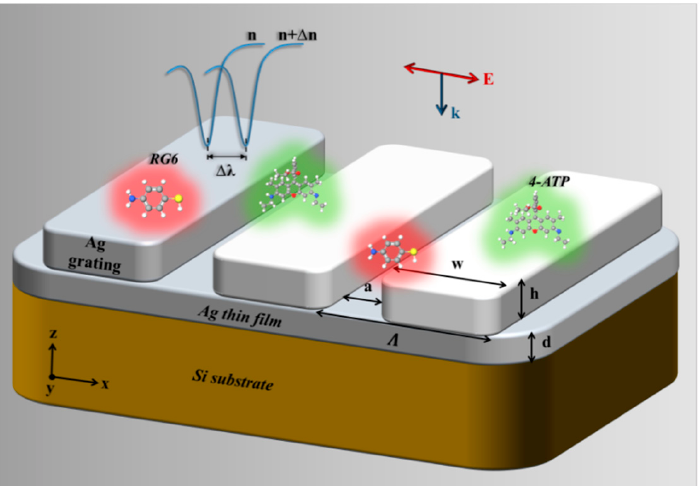
Figure 9. General schematic of the metallic grating on thin MF geometry under free-space excitation (normal incidence and TM polarization) for multimodal sensing. The RG6 and 4-ATP molecules were embedded to demonstrate the potential of the reflecting grating for SEF and SERS applications, respectively. The sensing application of the structure is demonstrated by the blue curves at the top-left part of the figure. Changing the refractive index of the surrounding material from n to n + Δ n leads to a change in the wavelength of the minimum of the reflectance spectra.